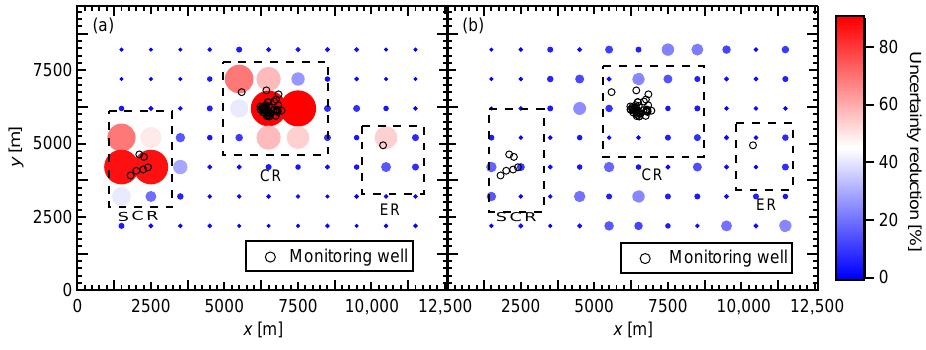
Figure 7. Reductions in pre-calibration uncertainties for the ( a ) upper- and ( b ) lower-layer pilot points upon application of the observation data set (43 head